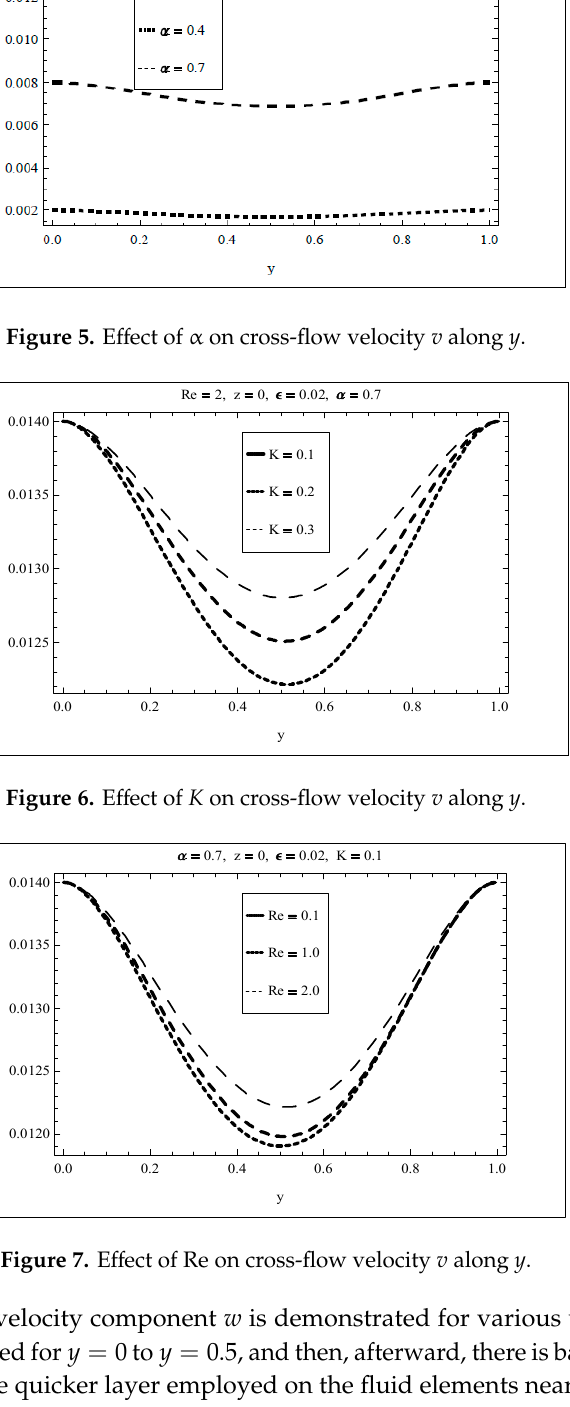
Figure 7. Effect of Re on cross-flow velocity v along y .